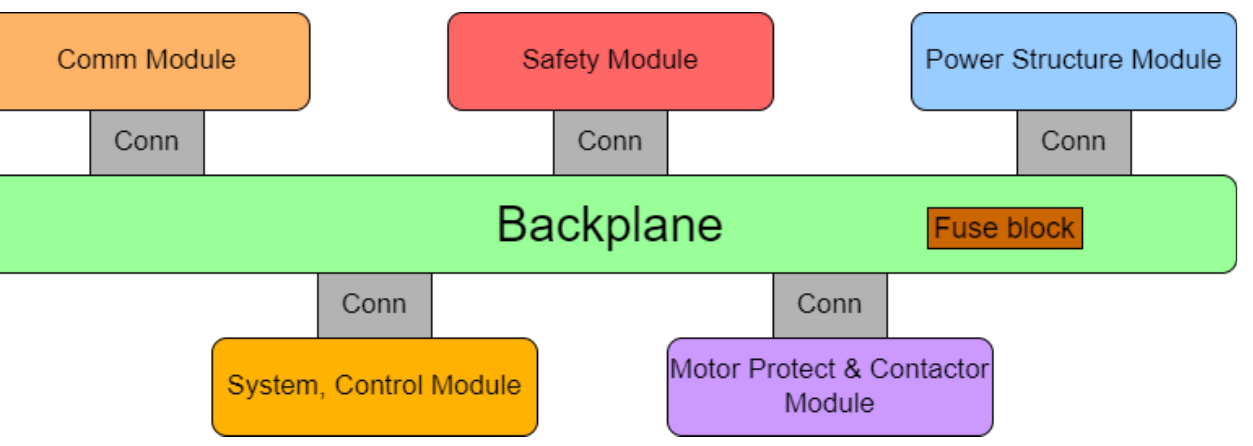
Figure 1. Simplified product